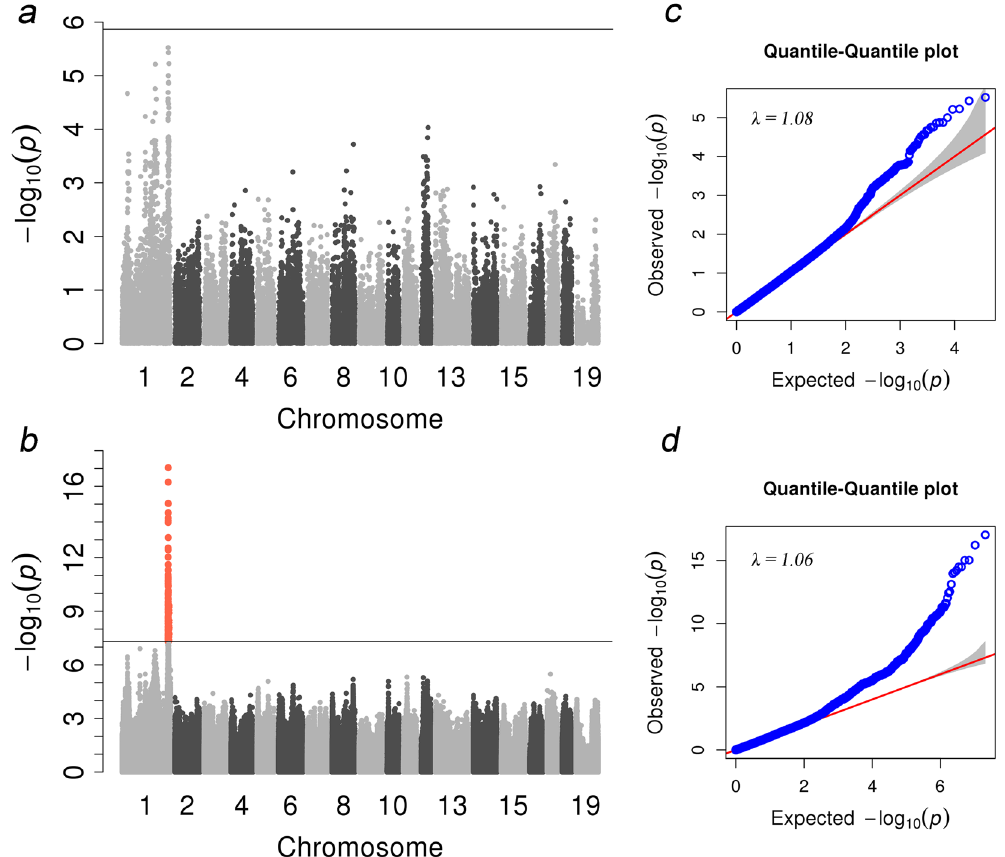
Figure 2. GWAS results for lumbar number trait. ( a , b ) Manhattan plots for lumbar number with the data before imputation ( a ) and after imputation ( b ). ( c , d ) c and d are the quantile-quantile plots. In the Manhattan plots, the y-axis and x-axis represent the negative log 10 P value of the SNPs and the genomic positions separated by chromosomes, respectively. In Manhattan plot a, black solid lines indicate the 5% genome-wide Bonferroni-corrected threshold. In Manhattan plot b, the tomato puree points represent SNPs that exceeded the chromosome-wide significance threshold ( − log10(5E-08)), and the black solid lines indicate the significance threshold. In quantile-quantile plots c and d, the y-axis and x-axis represent the expected and observed negative log 10 P value s,